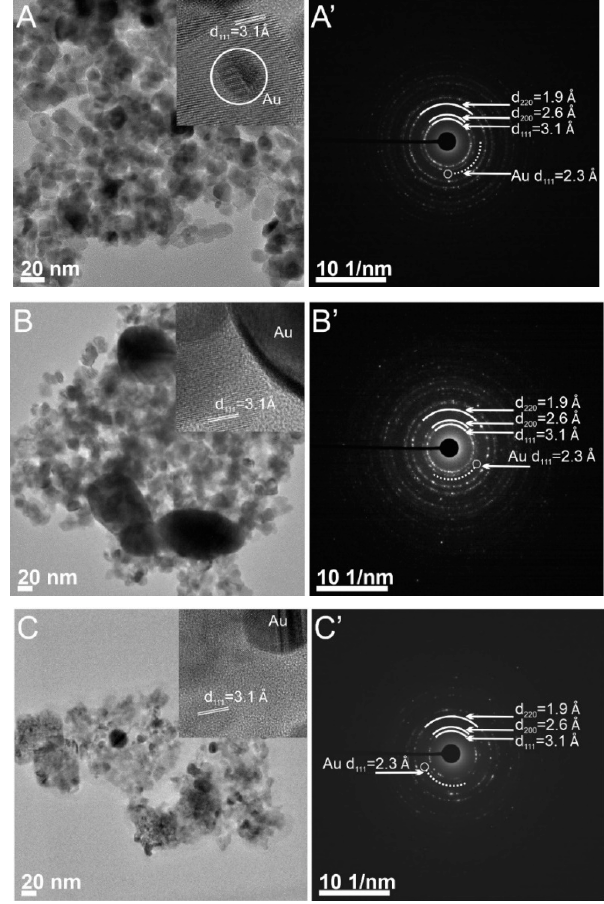
Figure 4. HRTEM images and Selected Area Electron Diffraction (SAED) patterns of Au-CeO 2 _N ( A , A’ ), Au-CeO 2 _H ( B , B’ ) and Au-CeO 2 _U ( C , C’ ). The insets in ( A – C ) show the interplanar distance between the (111) planes of CeO 2 and a single gold particle (dark region).